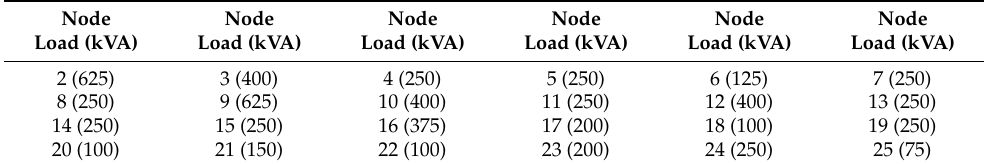
Table 5. Three-phase apparent power consumption at each node (lagging power factor of